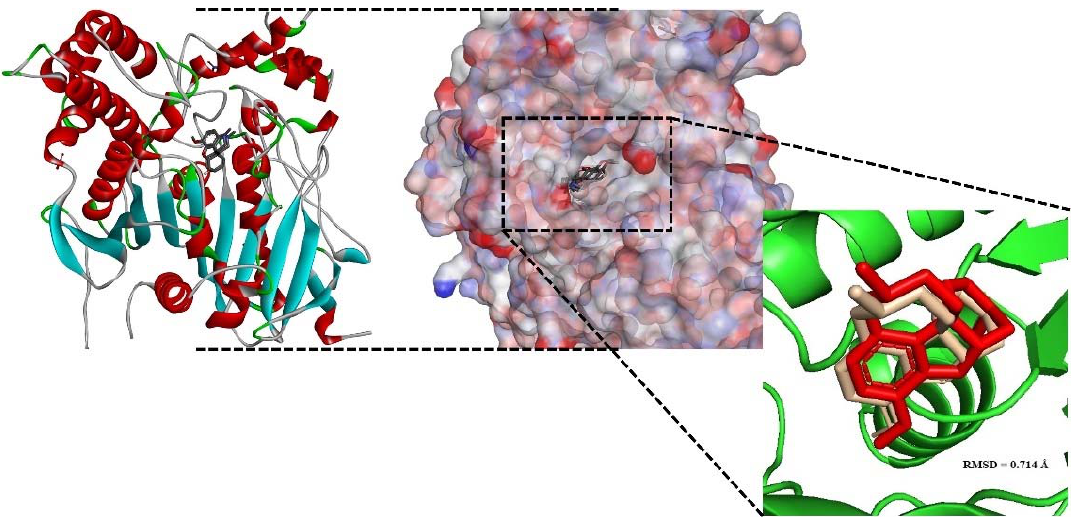
Figure 4. Dock pose overlay of crystallographic ligands (red) with the calculated shape (gray). The binding free energies, ligand efficacy, and residues participating in the interaction of the studied compounds are tabulated in Table 6. Dock score and MM ‐ GBSA estimation and residue interactions of the studied compounds against AChE enzyme .